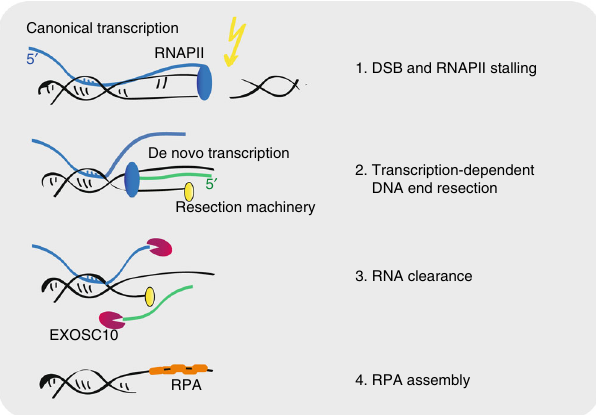
Fig. 8 Transcription and RNA degradation at DSBs. The fi gure presents a model for the role of transcription and RNA degradation at DSBs. See